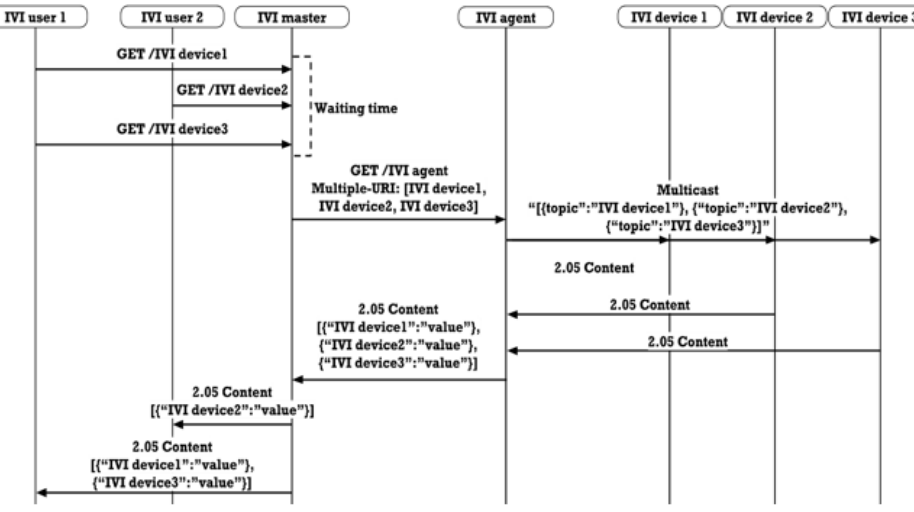
Figure 6. Operation flows of multiple URI communication .